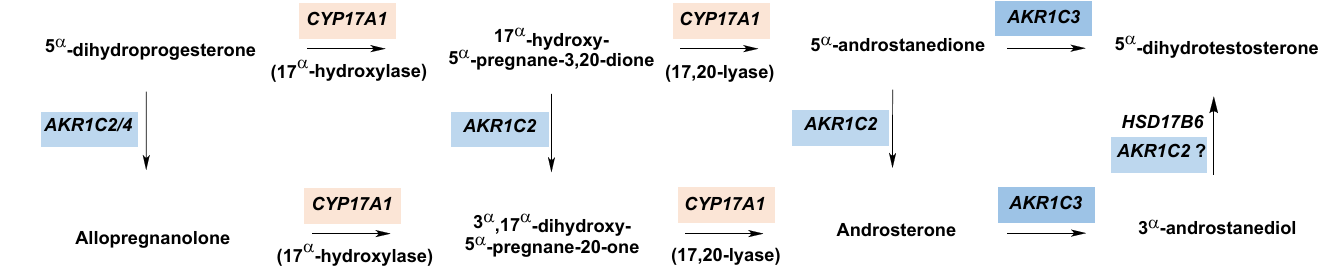
Figure 3. Role of AKR1C2 and AKR1C4 in the fetal backdoor pathway for DHT. Arrows depict reac- tions carried out by the indicated enzymes. The involvement of AKR1C2 is unconfirmed (indicated by a question mark) in the reaction converting 3 α -androstanediol to 5 α